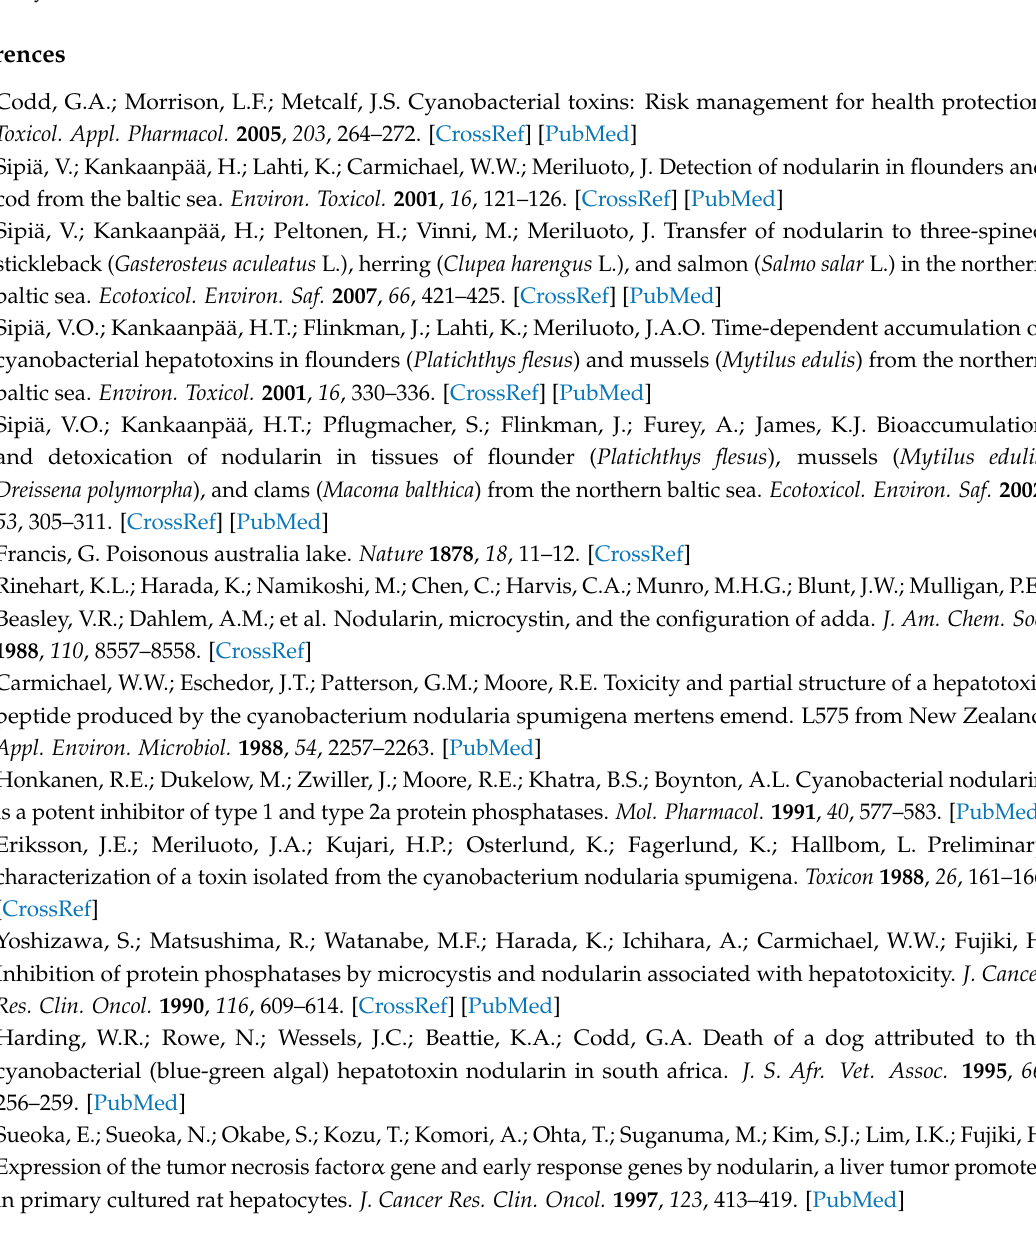
Table S1: Analyzed fish and other tissue samples, Figure S1: Analysis of fish and tissue samples with the NOD-specific